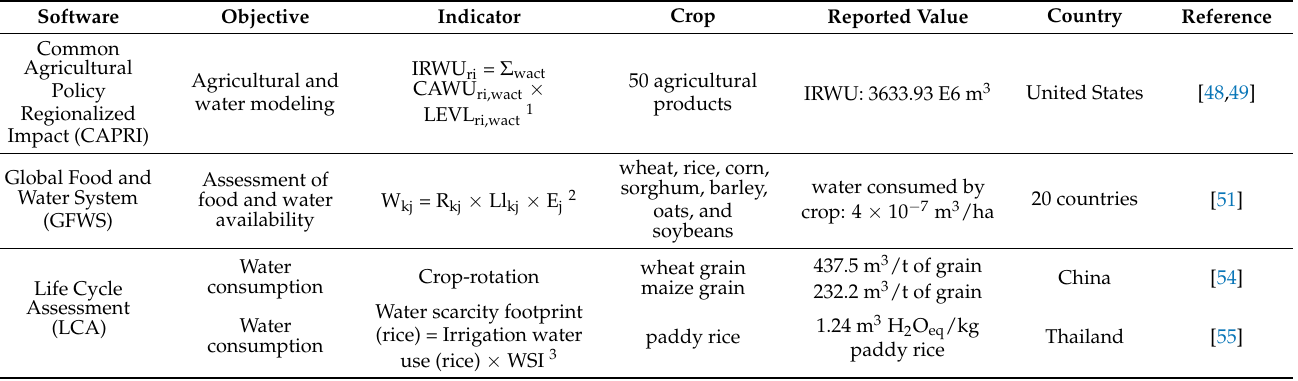
Table A1. Assessment programs for the Water–Food Nexus: case